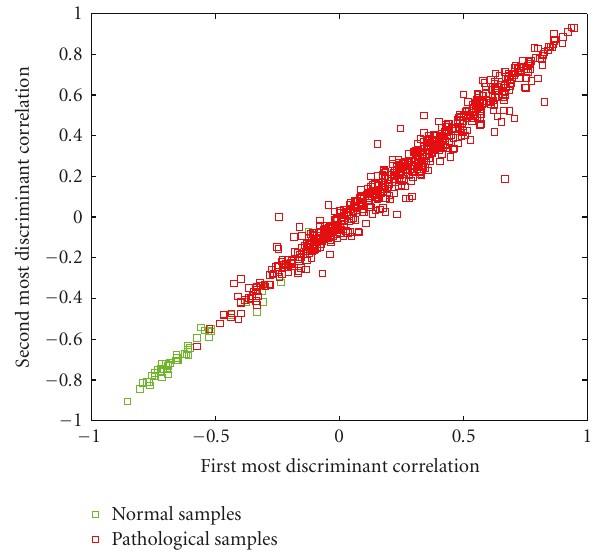
Figure 12: Location of the normal and pathological samples of the training set in the “two most discriminative correlations” representation space (Normal: green; Pathological: red).